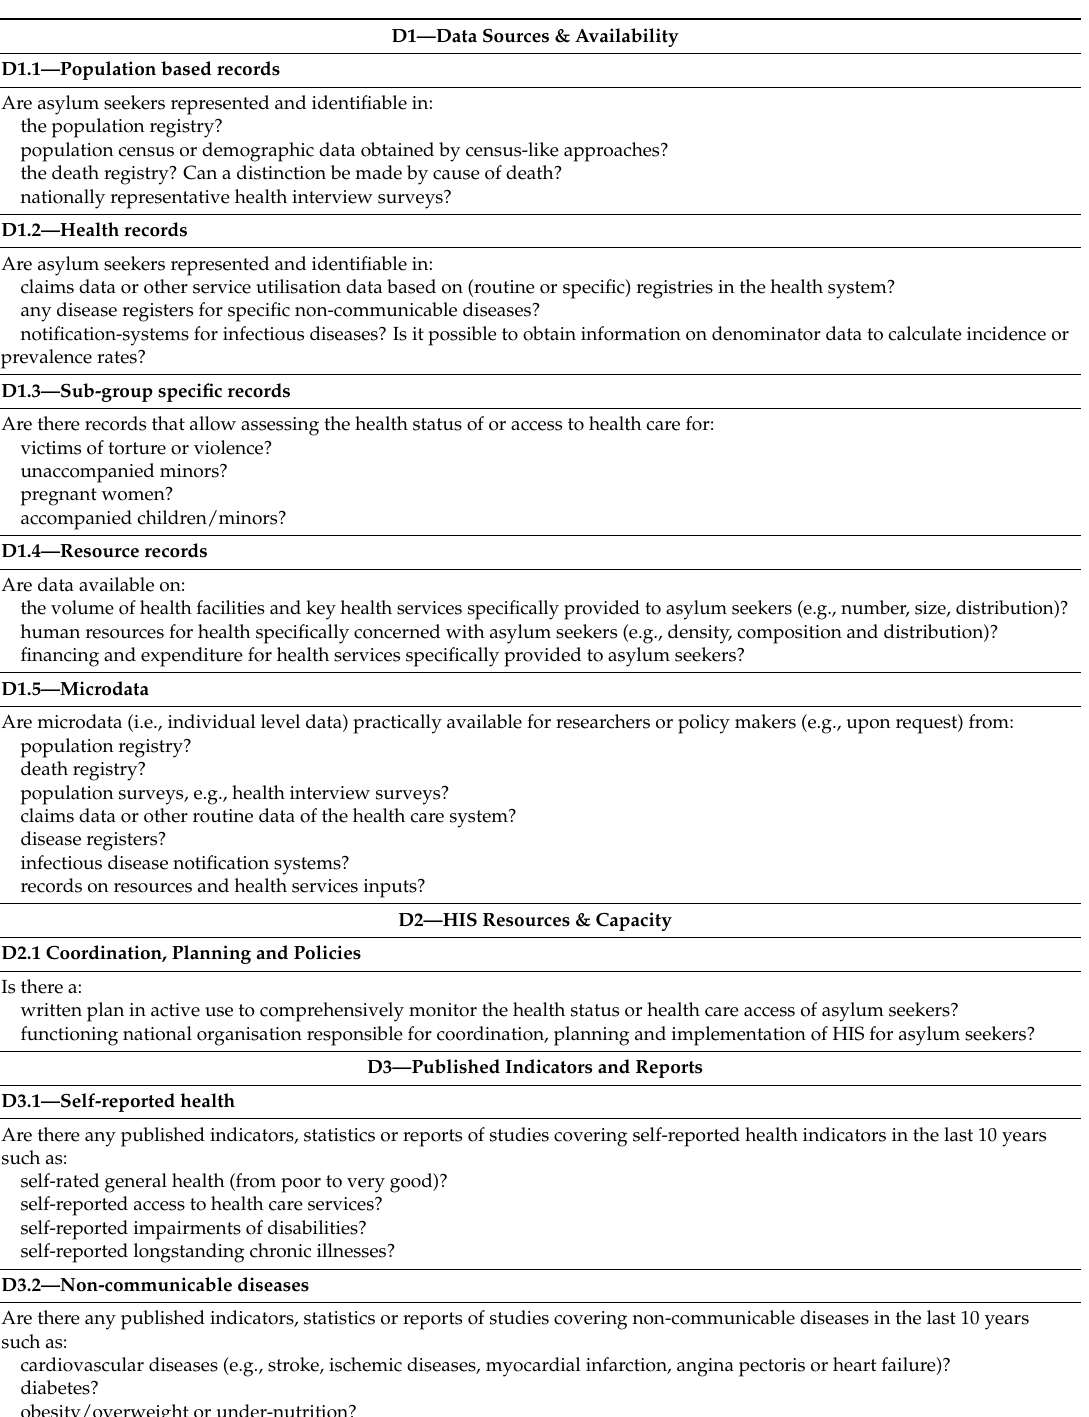
Table 1. Dimensions, sub-scales and items of HIATUS (version